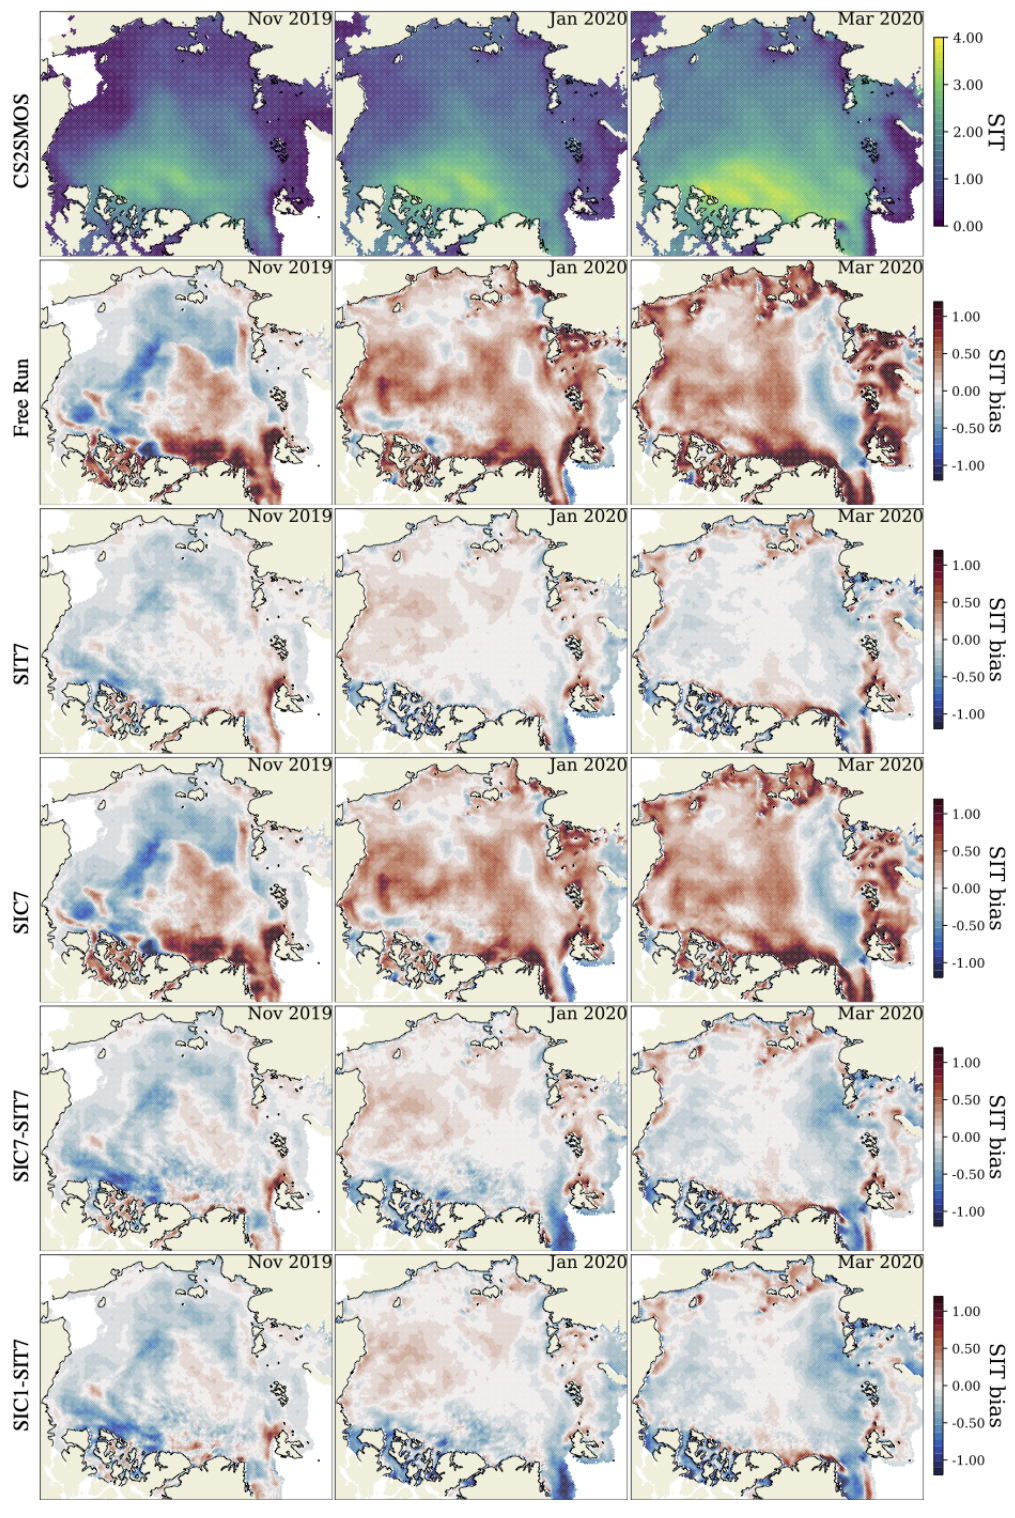
Figure 7. Same as Fig. 5 but for monthly averaged SIT bias between the ensemble runs and the CS2SMOS SIT product.